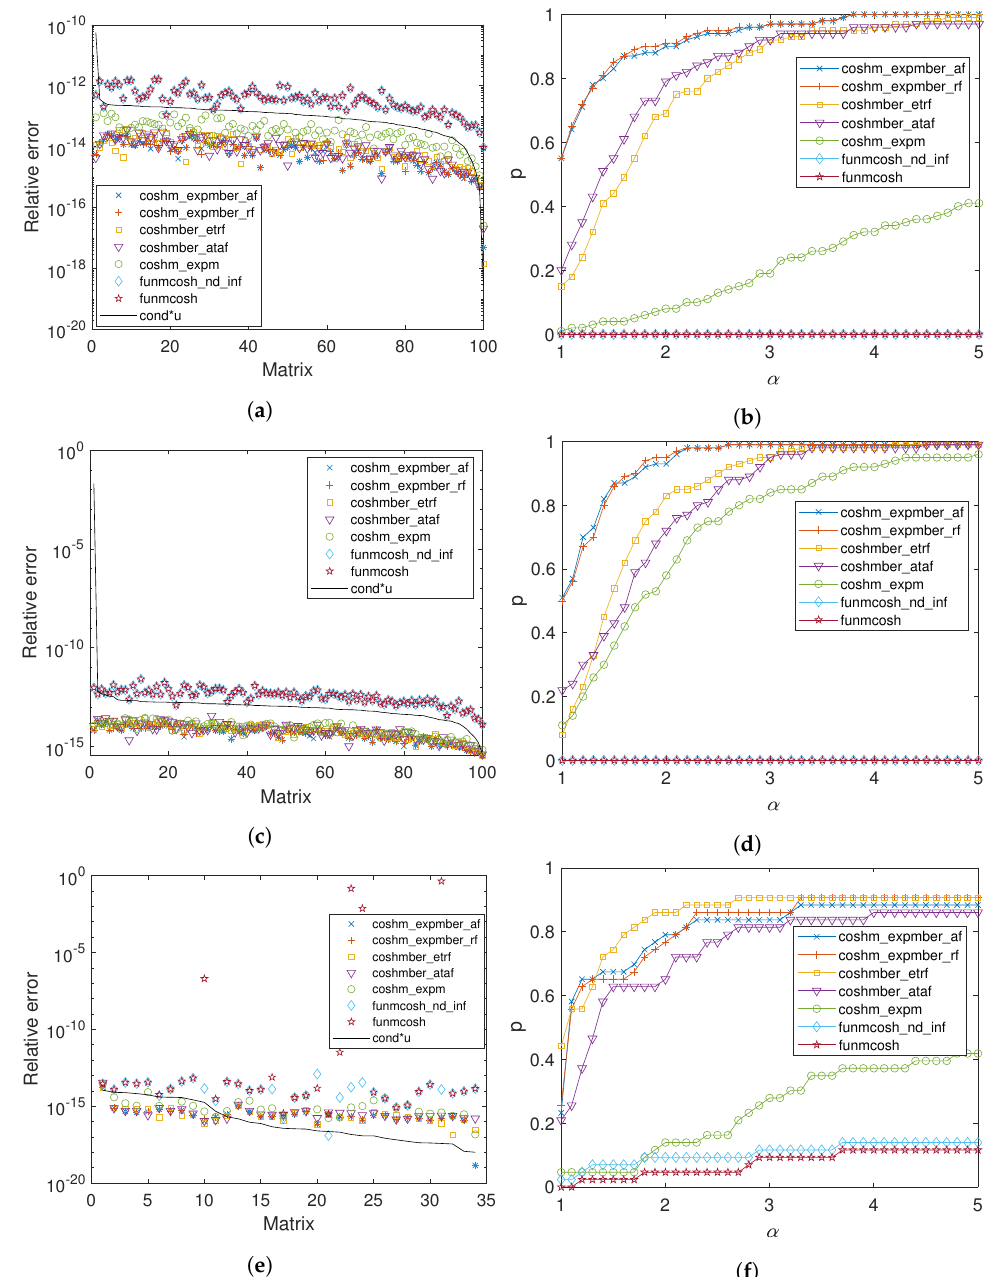
Figure 4. Experiment 2: Normwise relative errors for matrix sets 1 ( a ), 2 ( c ) and 3 ( e ) and performance plots for the same sets ( b , d , f